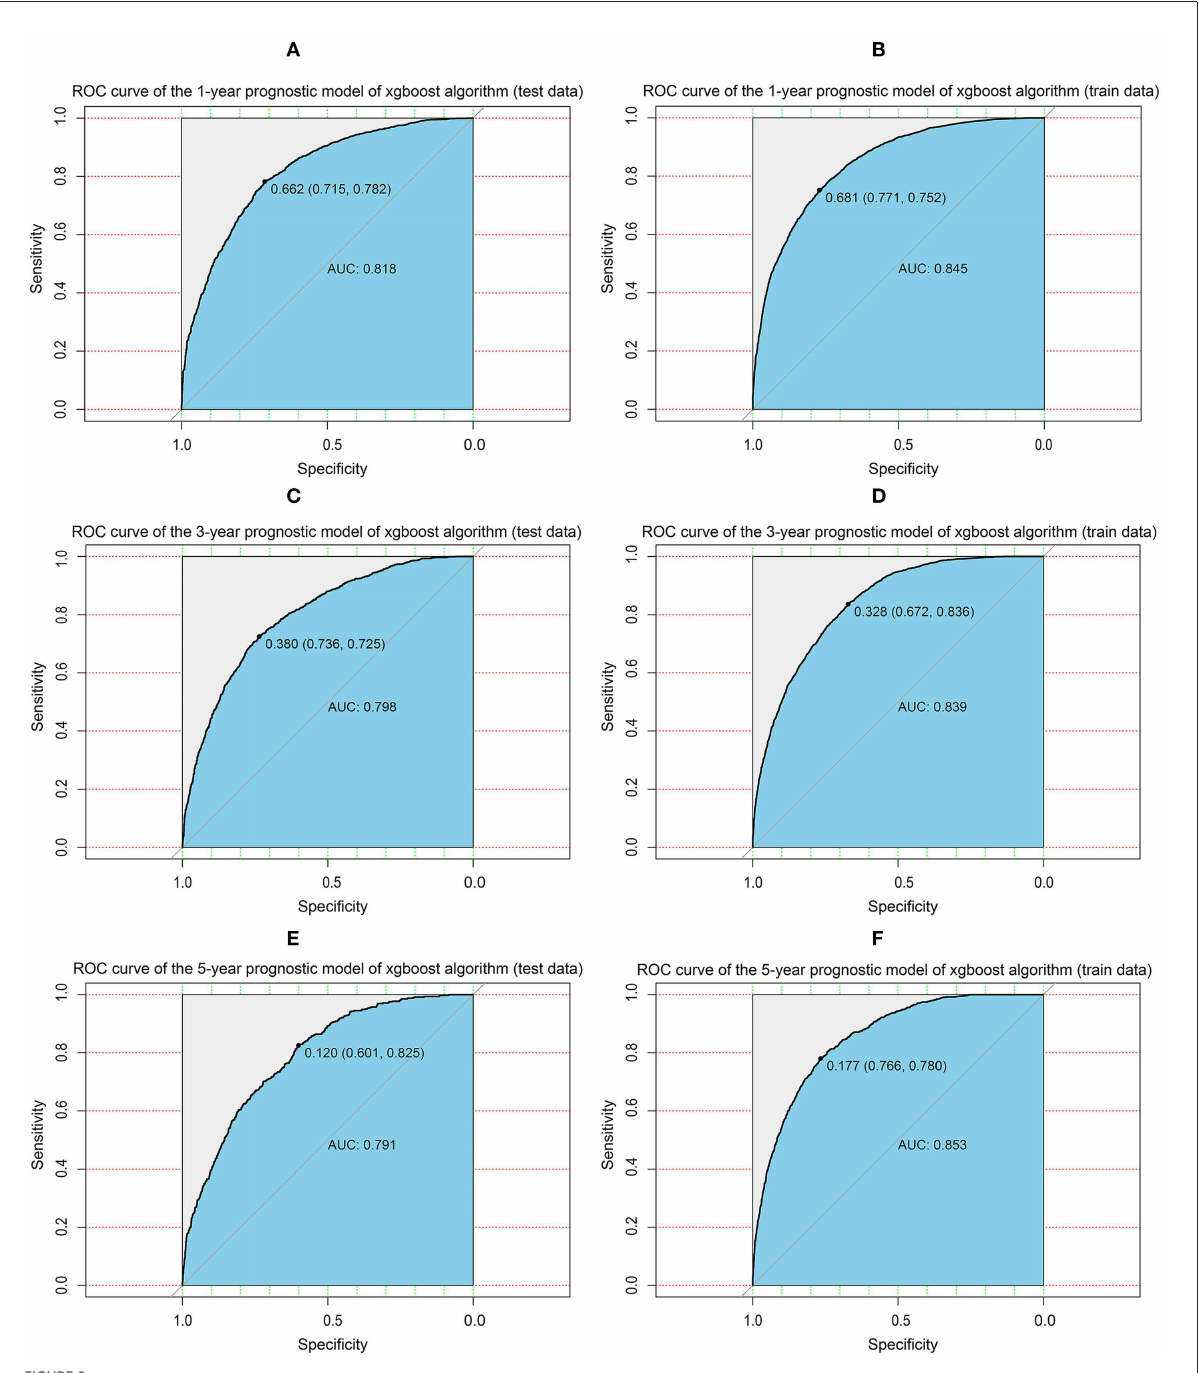
FIGURE6 XGBoost model evaluation. (A) ROC curve for the 1-year prognostic model (test data); (B) ROC curve for the 1-year prognostic model (train data); (C) ROC curve for the 3-year prognostic model (test data); (D) ROC curve for the 3-year prognostic model (train data); (E) ROC curve for the 5-year prognostic model (test data); (F) ROC curve for the 5-year prognostic model (train data); ROC, receiver operating characteristic curve; AUC, area under the curve; XGBoost, extreme gradient boosting.